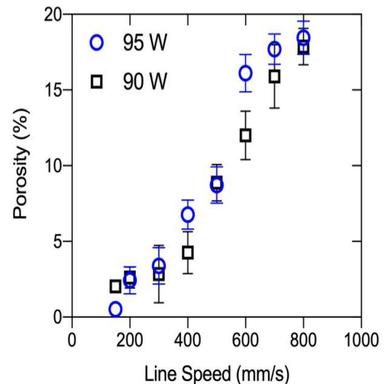
Porosity of Al-14Zn-3Mg at different scan speeds for two different laser powers, namely 90 W and 95 W. The relative density of the sample with minimum porosity is 99.49%.